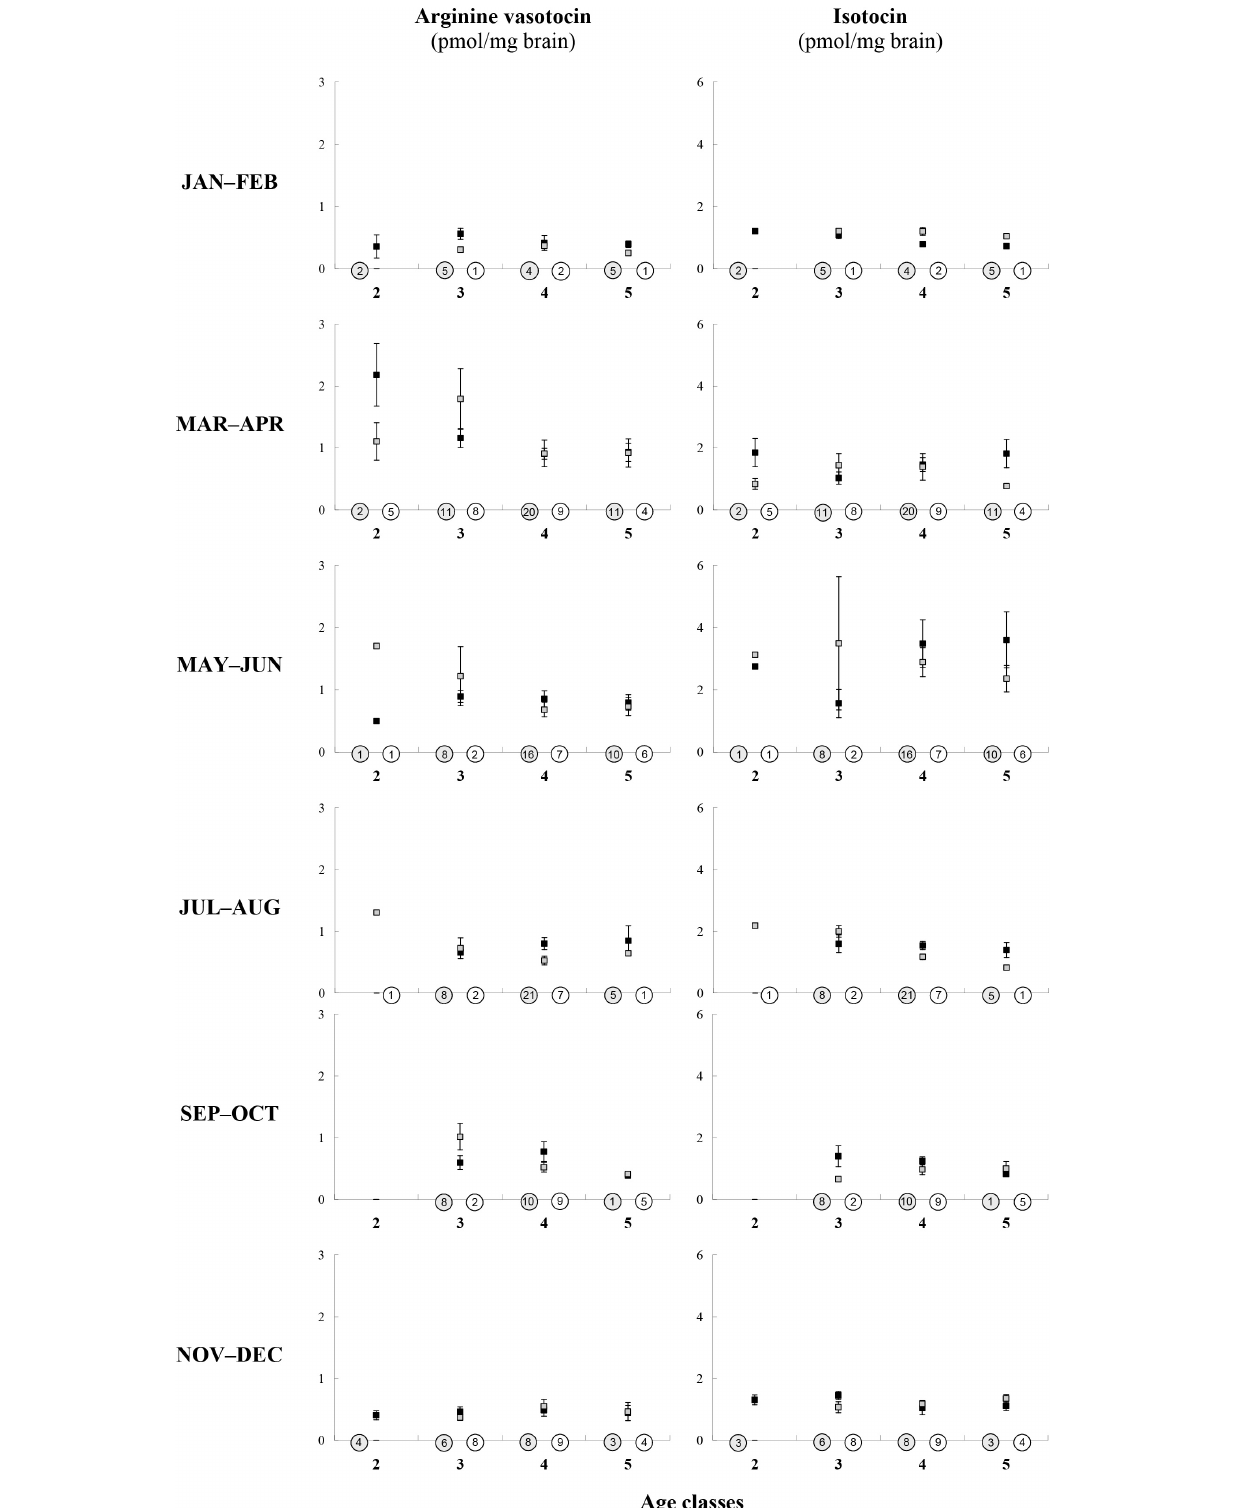
Frontiers in Marine Science |